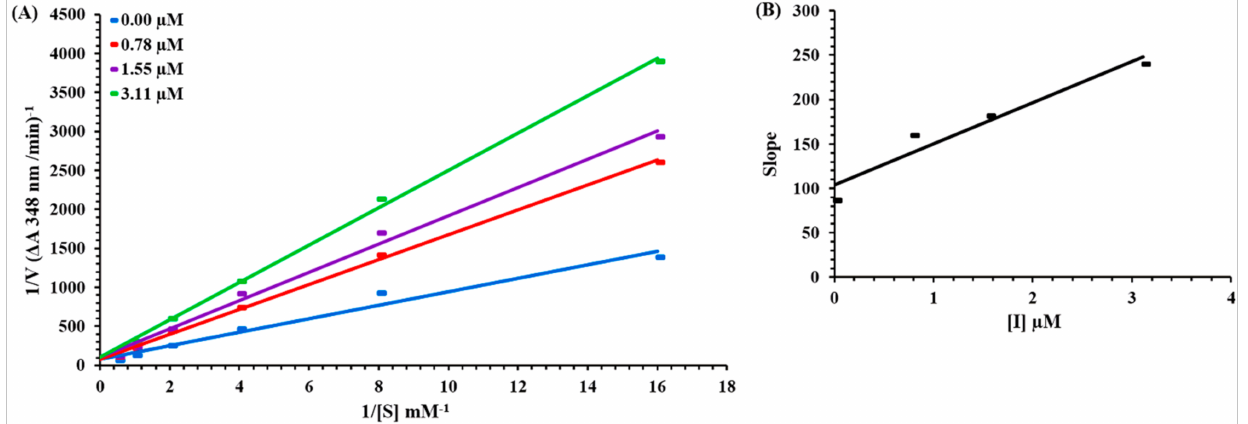
Figure 3. Lineweaver–Burk plots for carbonic anhydrase inhibition in the presence of compound 6e at concentration 0.00, 0.78, 1.55, and 3.11 µ M represented by blue-, red-, purple-, and green-colored lines, respectively ( A ). The insets depict the slope vs. inhibitor 6e concentration plot for determining the inhibition constant ( B